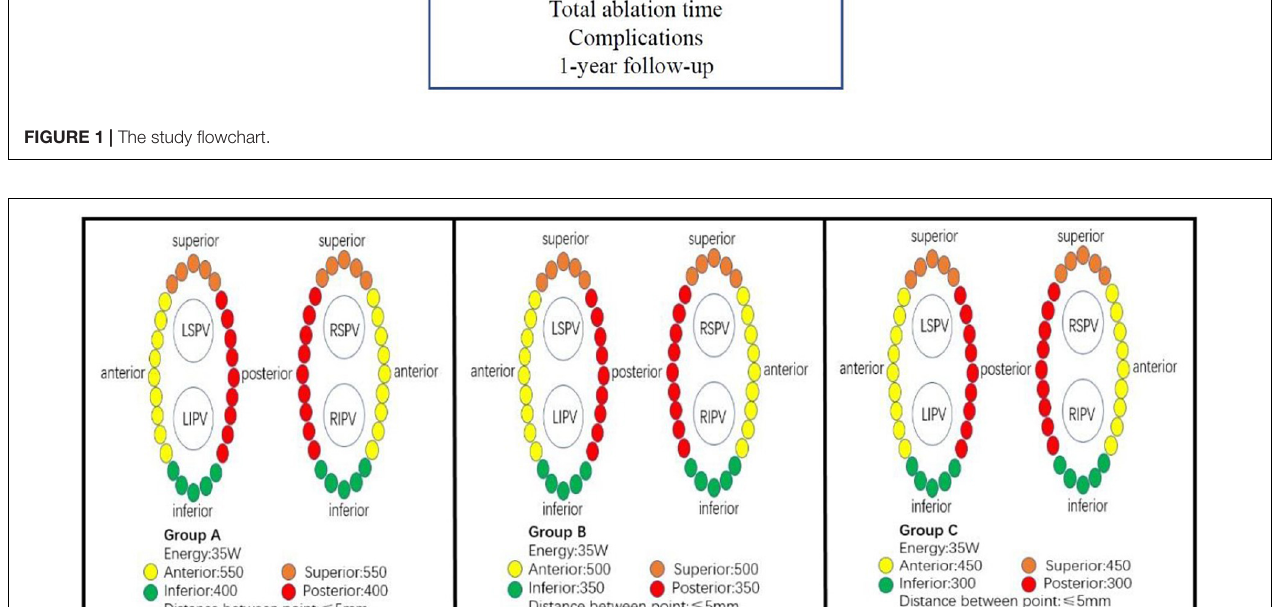
FIGURE 2 | Pulmonary vein segments and ablation protocol in Group A/B/C.